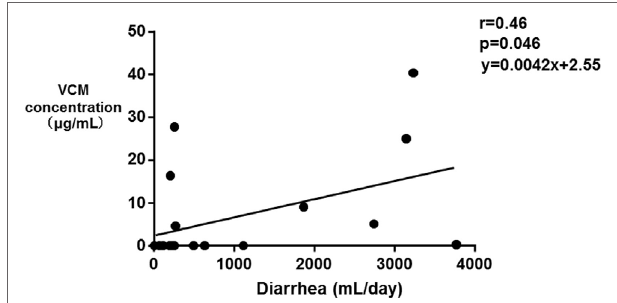
FigUre 2 | Correlation between the serum vancomycin (VCM) concentrations and the amount of diarrhea. Each plot depicts a relationship between the amount of diarrhea (milliliter per day) on the x -axis and the serum VCM concentration (microgram per milliliter) on the y -axis. A significant correlation between the serum VCM concentrations and the amount of diarrhea was observed ( r = 0.46, p = 0.046).